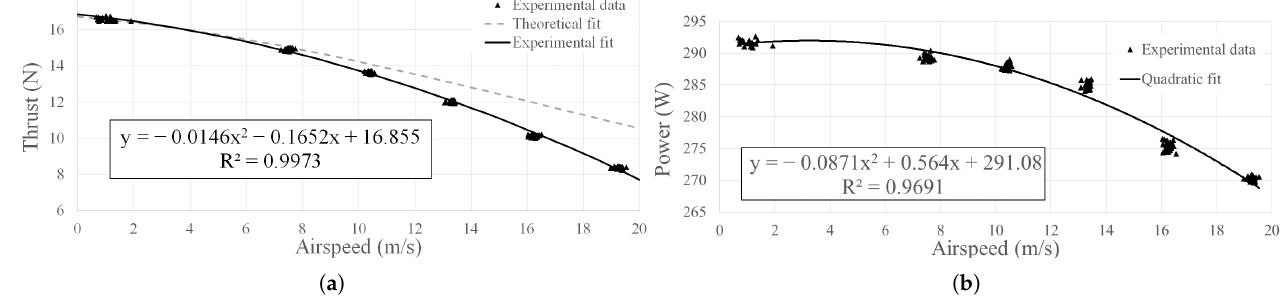
Figure 6. Motor response at full throttle. ( a ) Thurst. ( b ) Electric power.